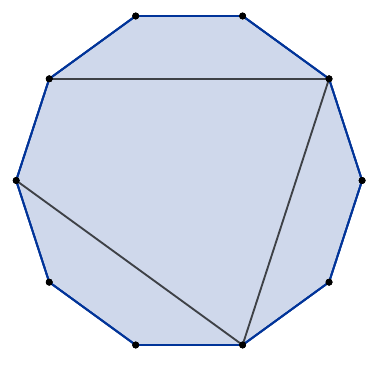
Figure 15 . Dissection (14 , 47 , 710)